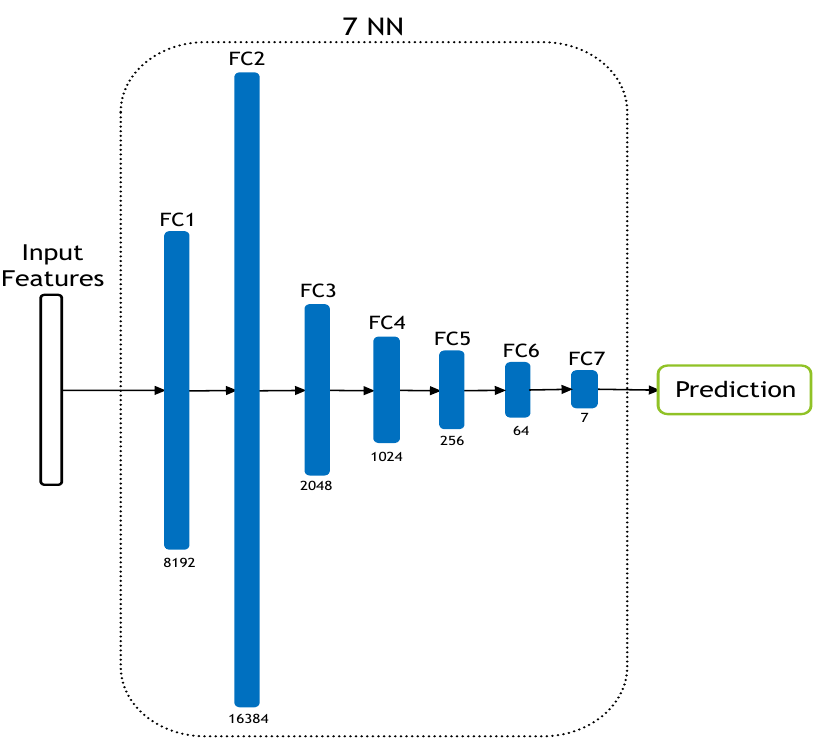
Figure 6. The used seven-layer NN classifier.